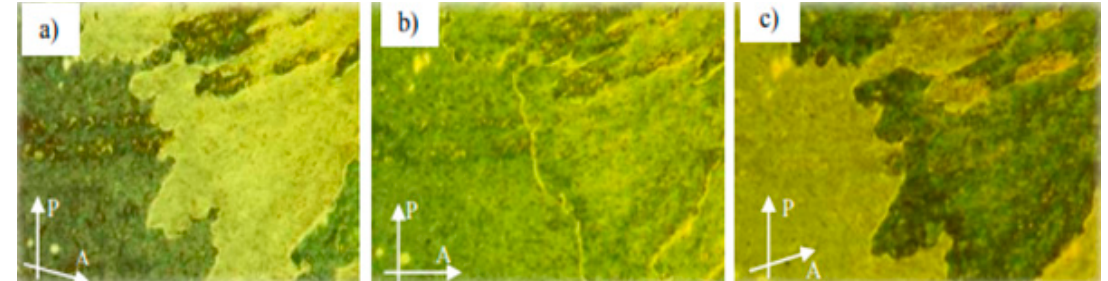
Figure 4. Textures of the chiral SmC s[ * ] phase of compound 13e at T = 127 °C, ( a , c ) between slightly uncrossed polarizers and ( b ) between crossed polarisers, exhibiting dark and bright domains that indicate the presence of chiral domains with opposite handedness. (Reproduced with permission from ref. [90], copyright John Wiley and Sons 2017, https://doi.org/10.1002/chem.201606035).